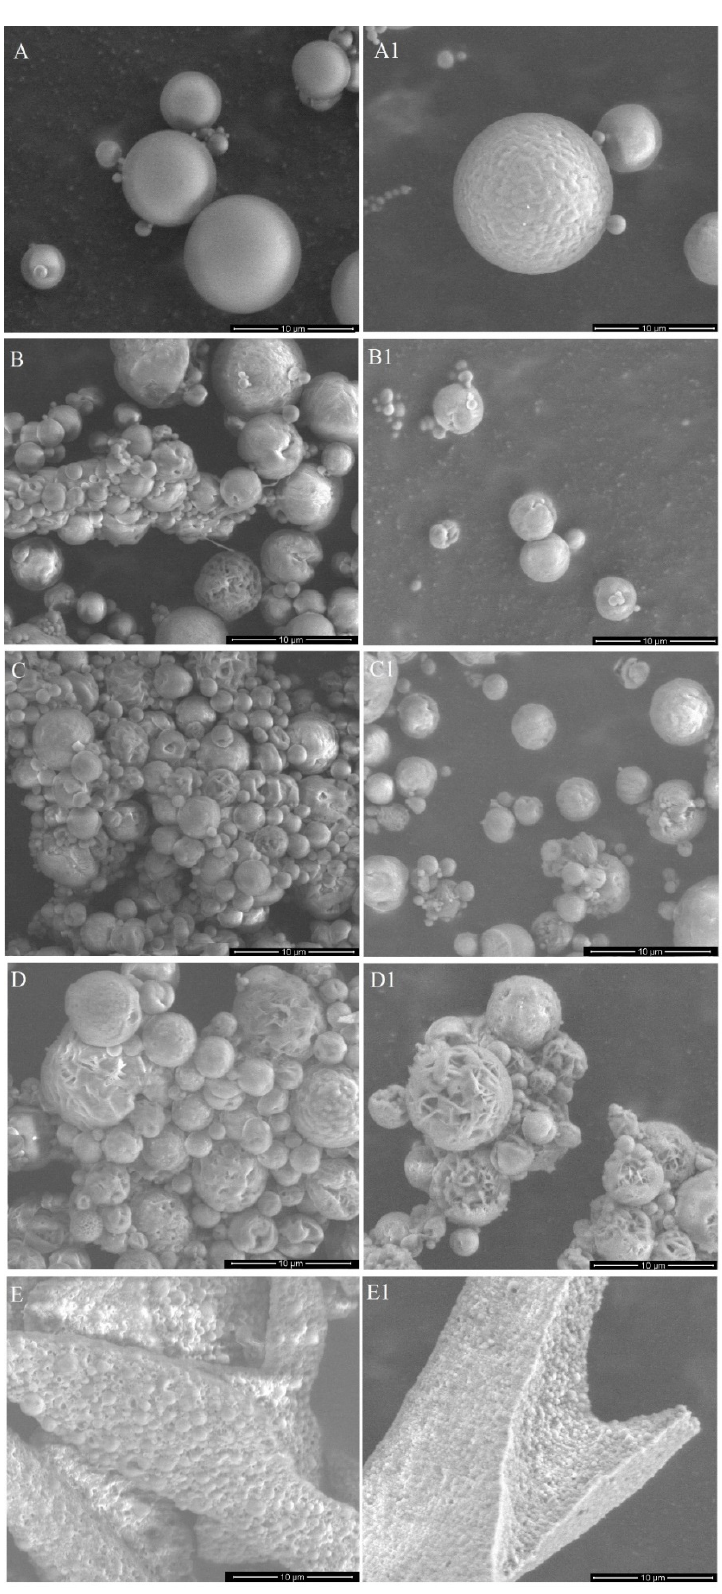
Figure 1. Morphology of the drug-free microspheres (MS) ( A – E ) and the microspheres (MS) loaded with epothilone B (EpoB) and rapamycin (Rap) ( A1 – E1 ), obtained from PLA 100/PLA–PEG 0 ( A , A1 ), PLA 75/PLA–PEG 25 ( B , B1 ), PLA 50/PLA–PEG 50 ( C , C1 ), PLA 25/PLA–PEG 75 ( D , D1 ), PLA 0/PLA–PEG 100 ( E , E1 ).